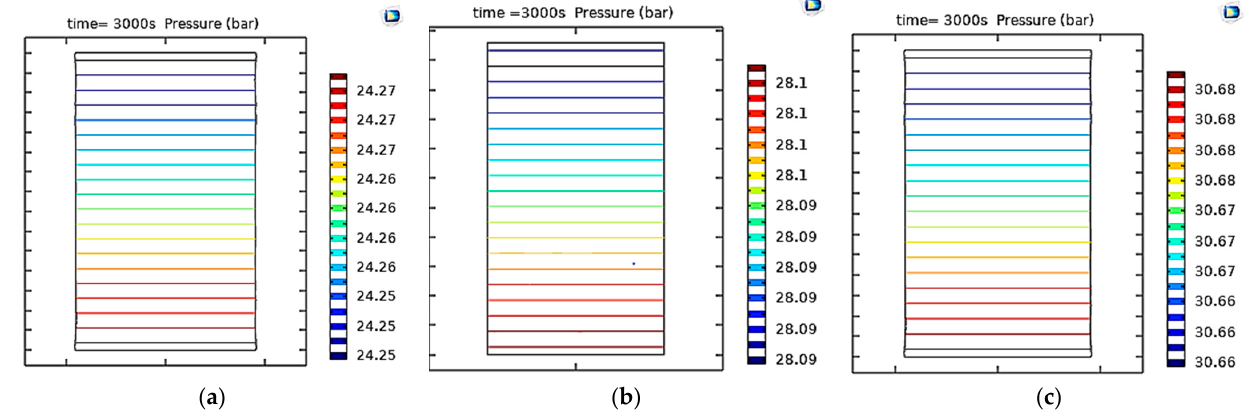
Figure 12. Isobars inside the reactor at 3000 s after the onset of the HTC process: Effect of the imposed wall thermal power, ( a ) q 0 = 2.0 kW; ( b ) q 0 = 2.3 kW; ( c ) q 0 = 3.0 kW.